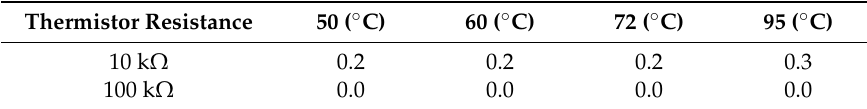
Table 1. Self-heating effect of 10 and 100 k Ω thermistor.